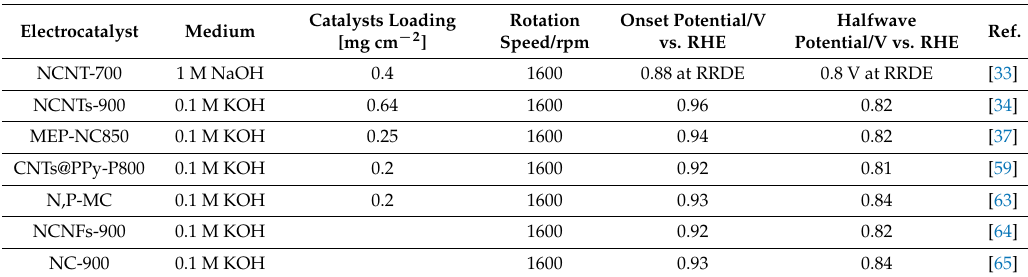
Table 2. Summary of metal-free electrocatalysts for